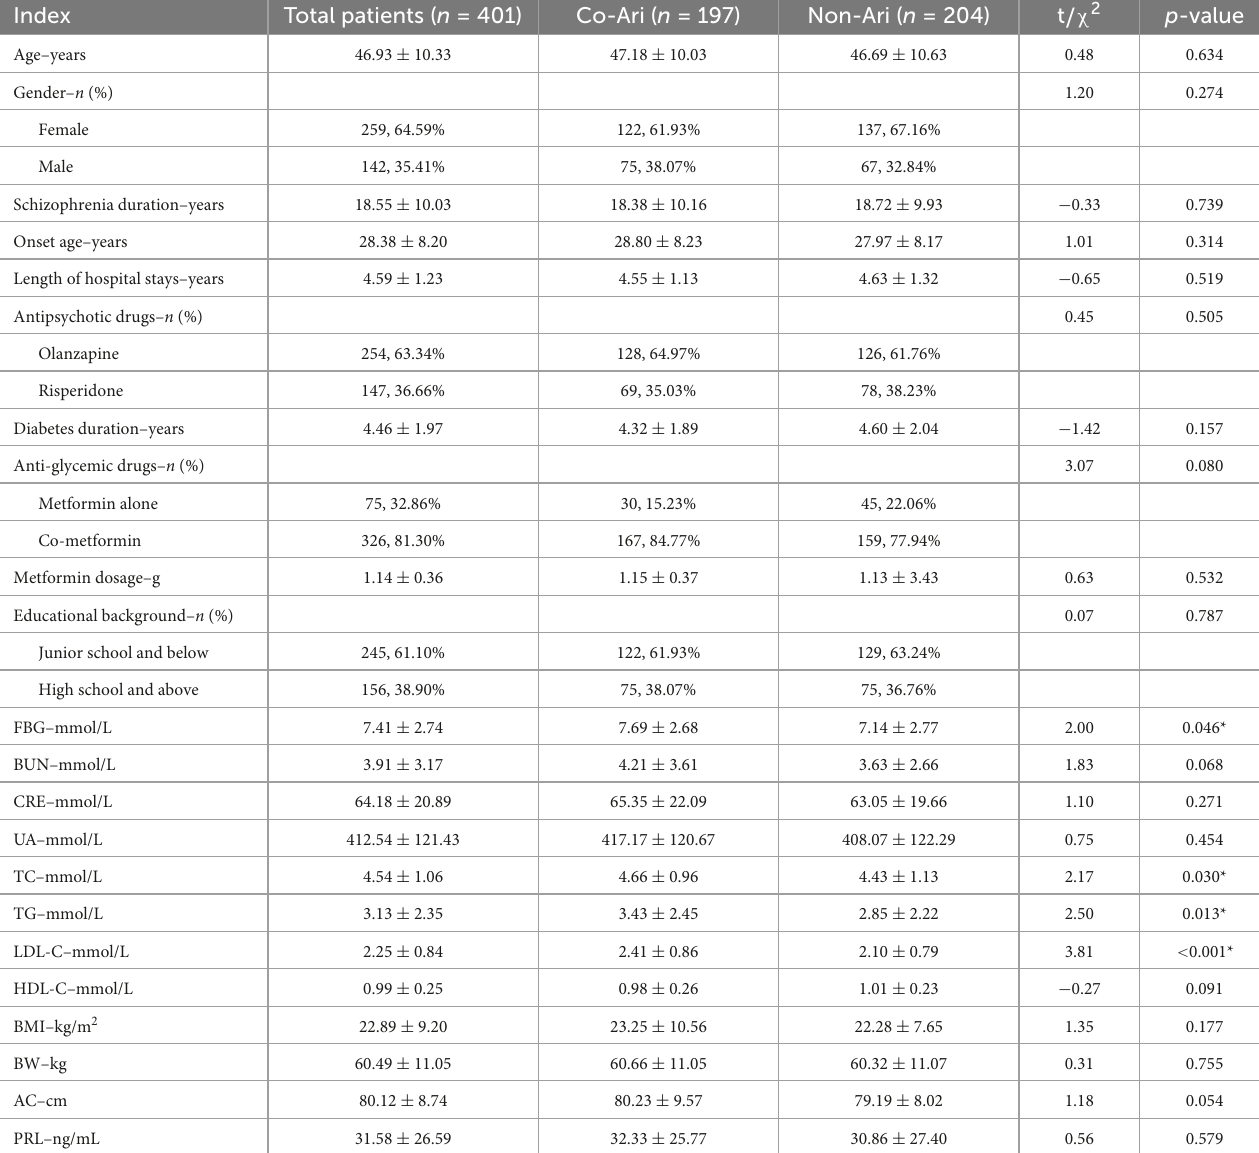
TABLE 1 Demographic and general clinical